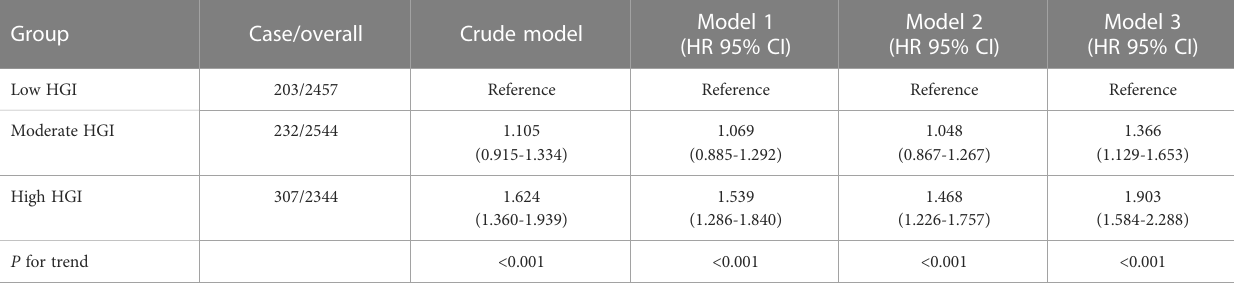
TABLE 2 Adjusted hazard ratios for incident diabetes according to the HGI category at baseline.